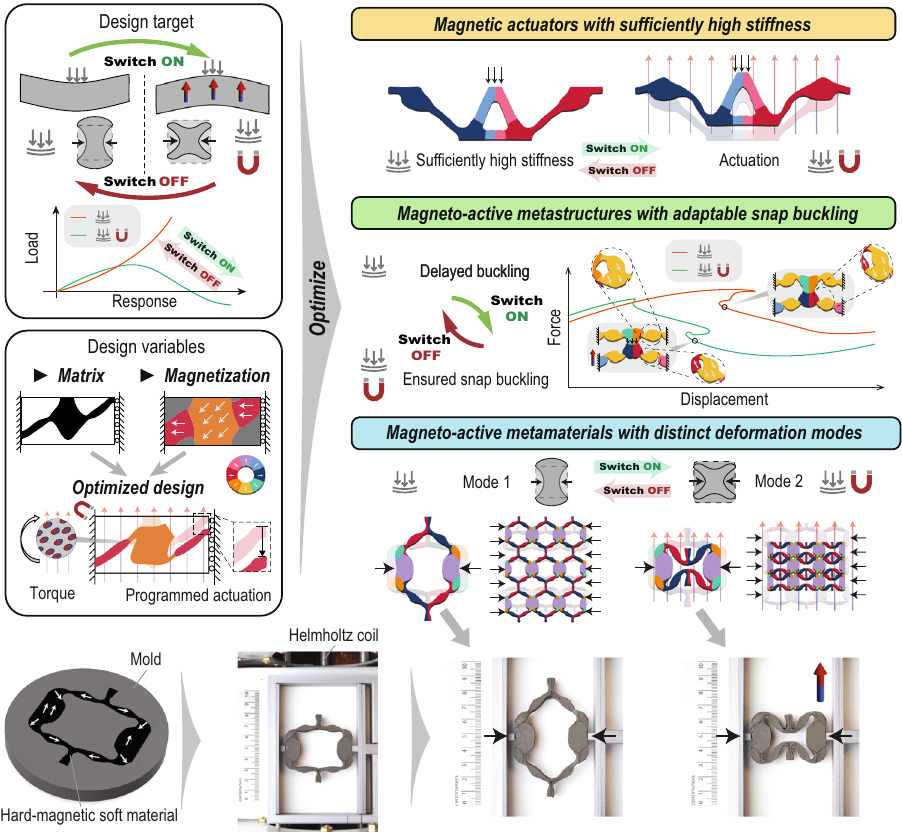
Fig. 1 Overview of the optimization-guided computational design approach and experimental validation for magneto-mechanical multi- functional metamaterials and structures. Given design domain and targets (top left), the proposed approach can optimize the three sets of design variables (middle left) to generate magneto-mechanical multi-functional metamaterials and structures (right), whose properties can be seamlessly reprogrammed by switching on and off the external stimuli. Fabrication and experimental validation (bottom) are developed to physically demonstrate the target reprogrammable behaviors are accurately